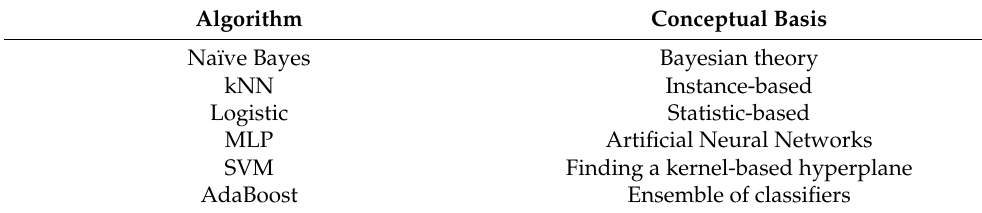
Table 2. Algorithms against which the D1-NN classifier will be compared.